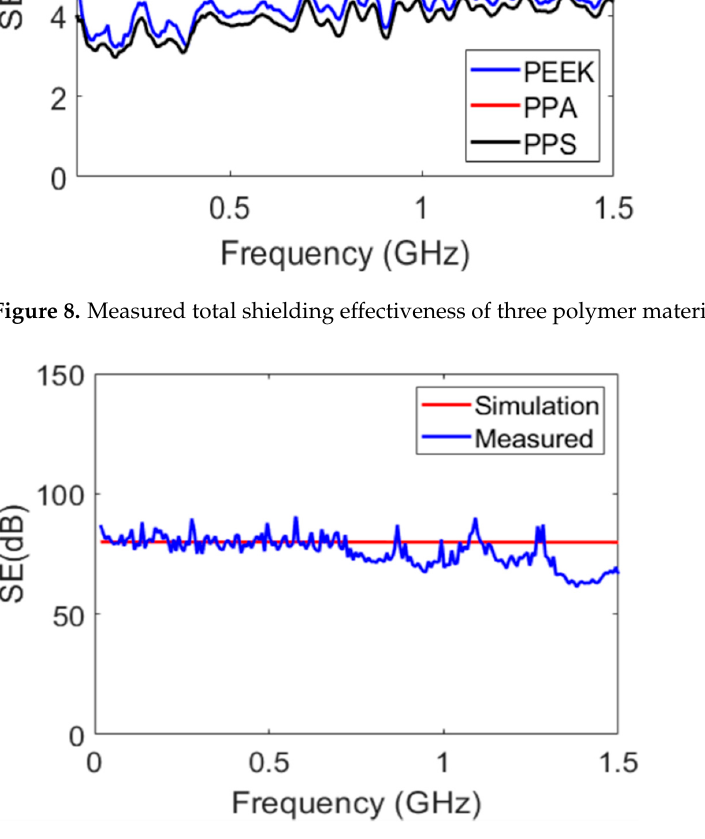
Figure 9. Comparison of the zinc EMI SE using an ANSYS simulation and experimental measure- ments.